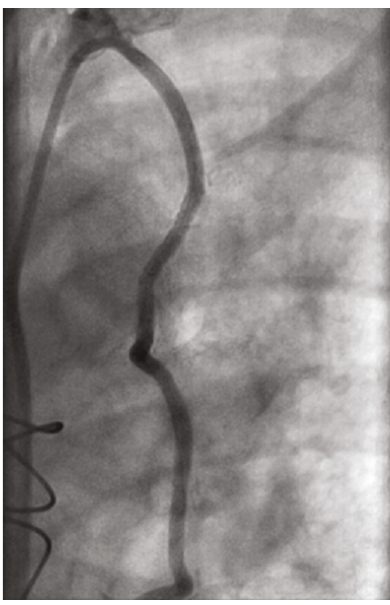
Figure 4: Postintervention angiography showing no residual aneurysm or stenosis in the left internal mammary artery bypass